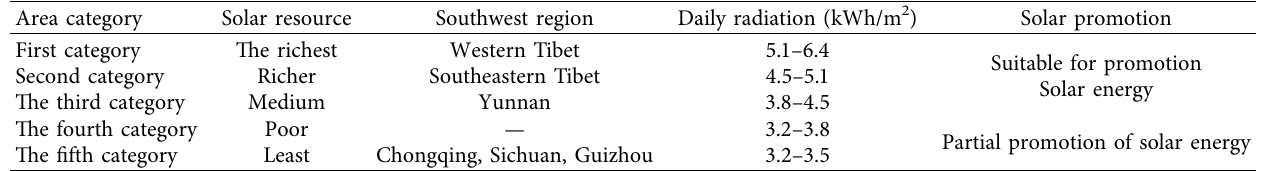
Table 2: Analysis of the distribution and promotion of solar energy resources in southwest China.